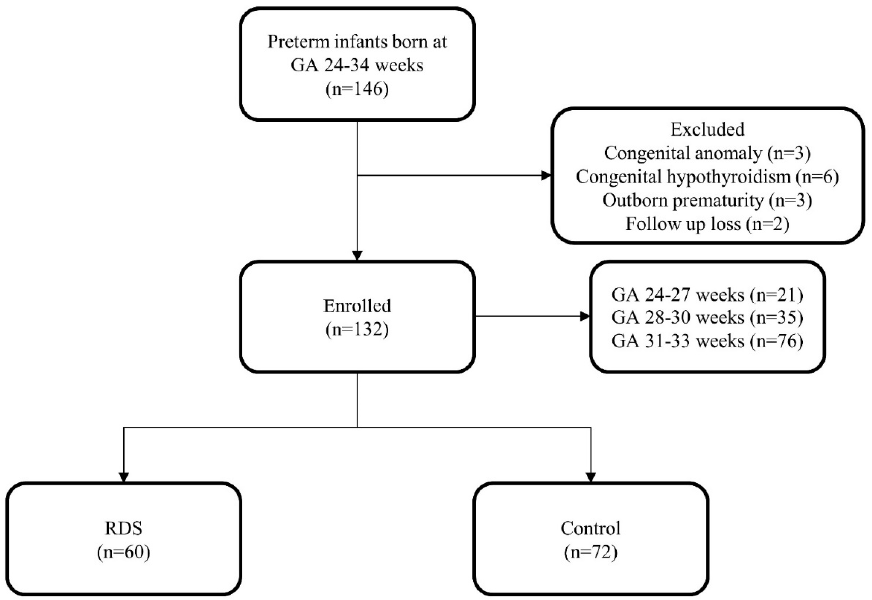
Figure 1. Study population.